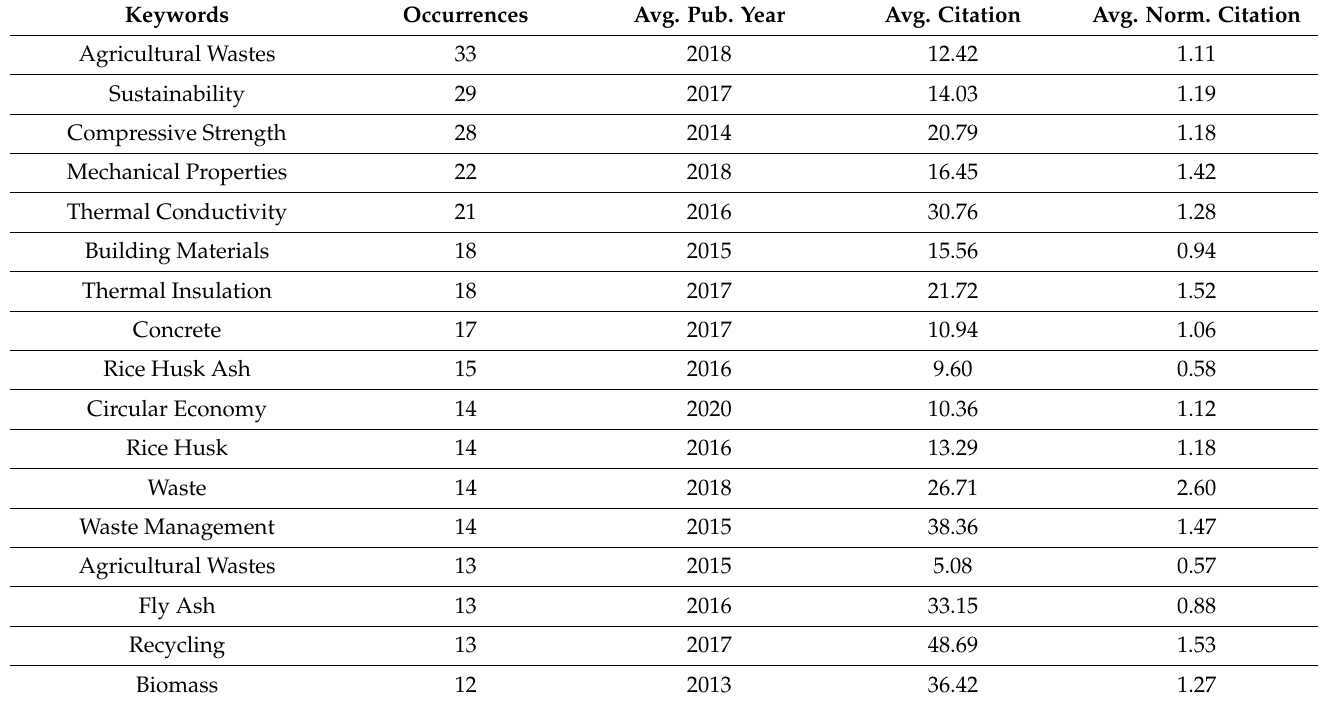
Table 2. Quantitative summary of influence of keywords.